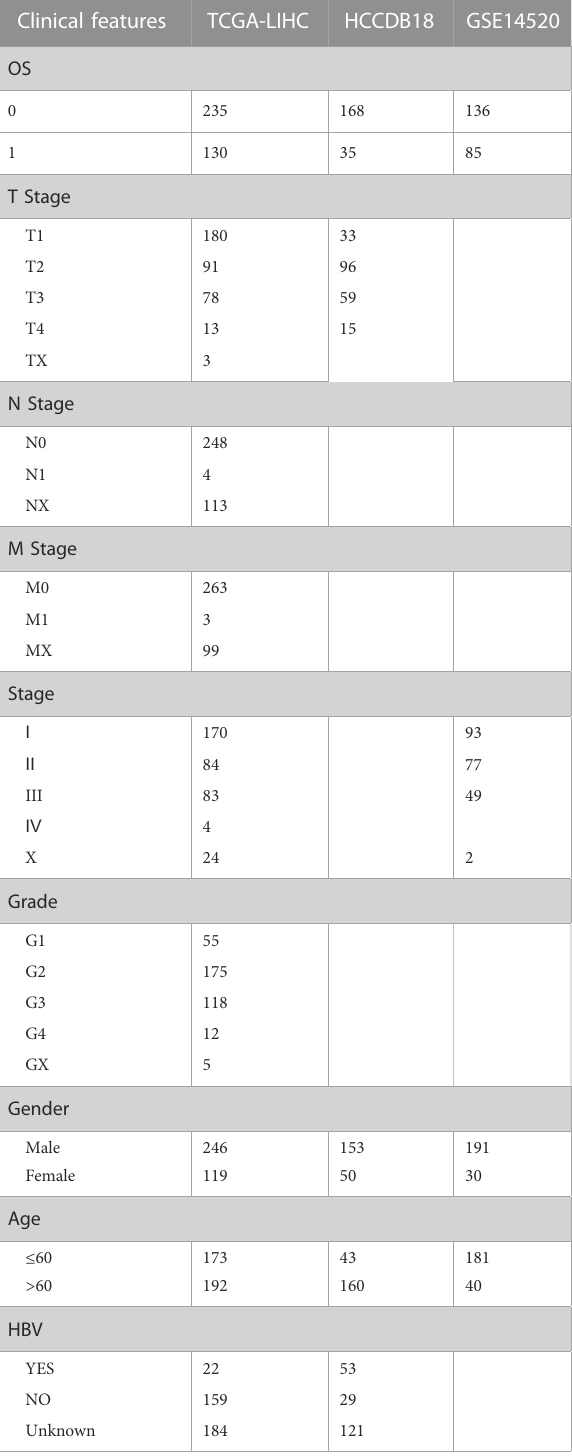
TABLE 1 The clinical information of three